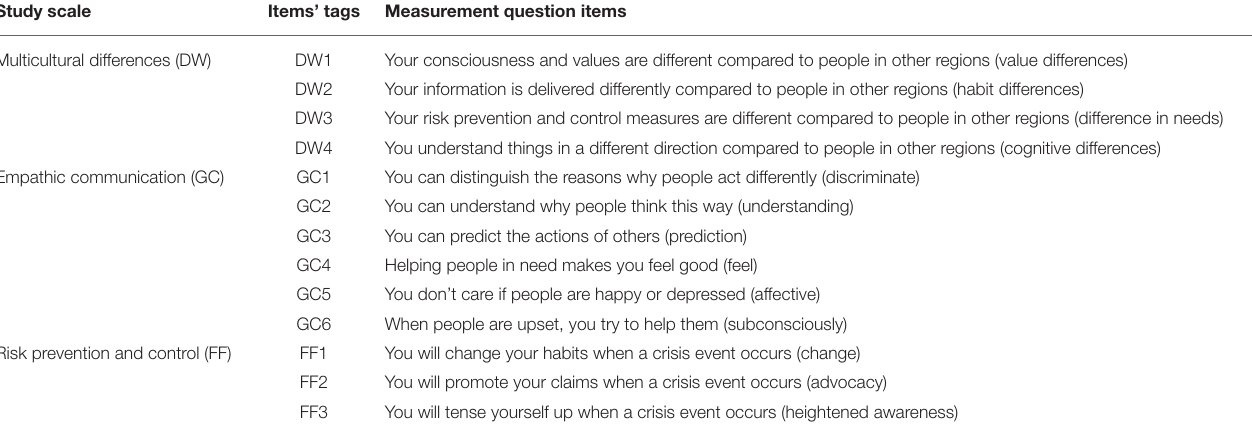
TABLE 1 | Study scale and question items. Study scale Items’ tags Measurement question items